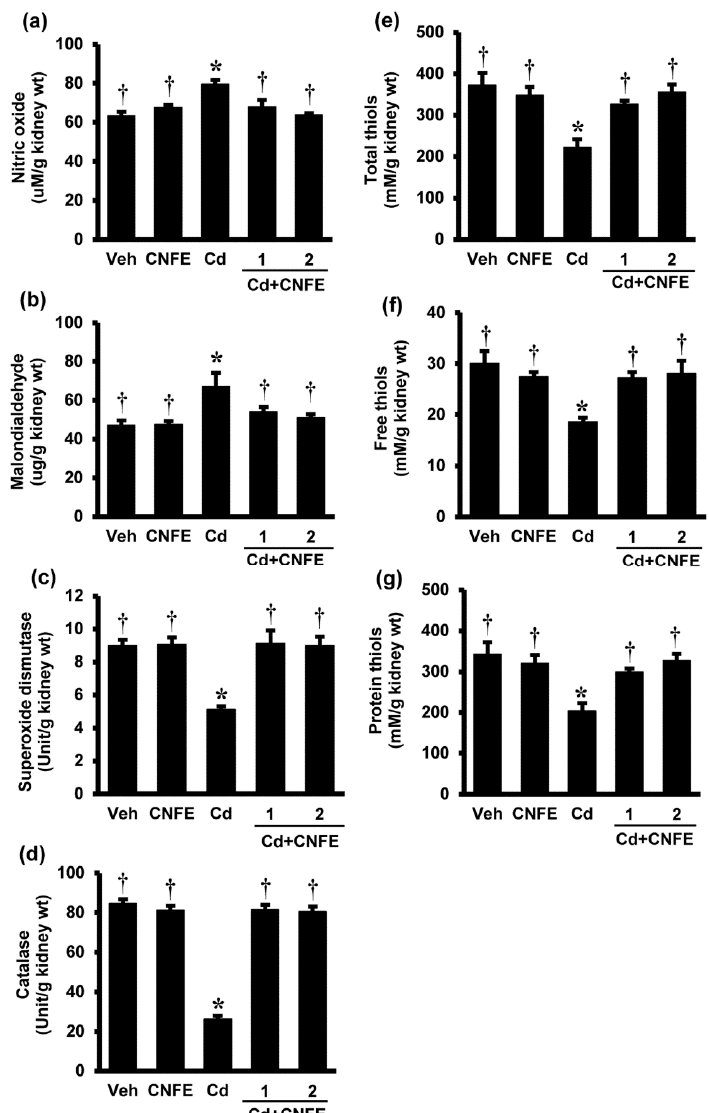
Figure 4. Effects of cadmium and CNFE on renal oxidative stress. ( a ) Nitric oxide; ( b ) malondialdehyde; ( c ) superoxide dismutase; ( d ) catalase; ( e ) total thiols; ( f )free thiols; and ( g ) protein thiols. Veh: vehicle-treated control group; CNFE: C. nervosum fruit extract-treated group; Cd: cadmium-treated group; Cd + CNFE (1 and 2): cadmium plus CNFE (1 and 2 g/kg)-treated groups. Values are mean ± SEM ( n = 6). * p < 0.05 vs. Veh, † p < 0.05 vs. Cd.